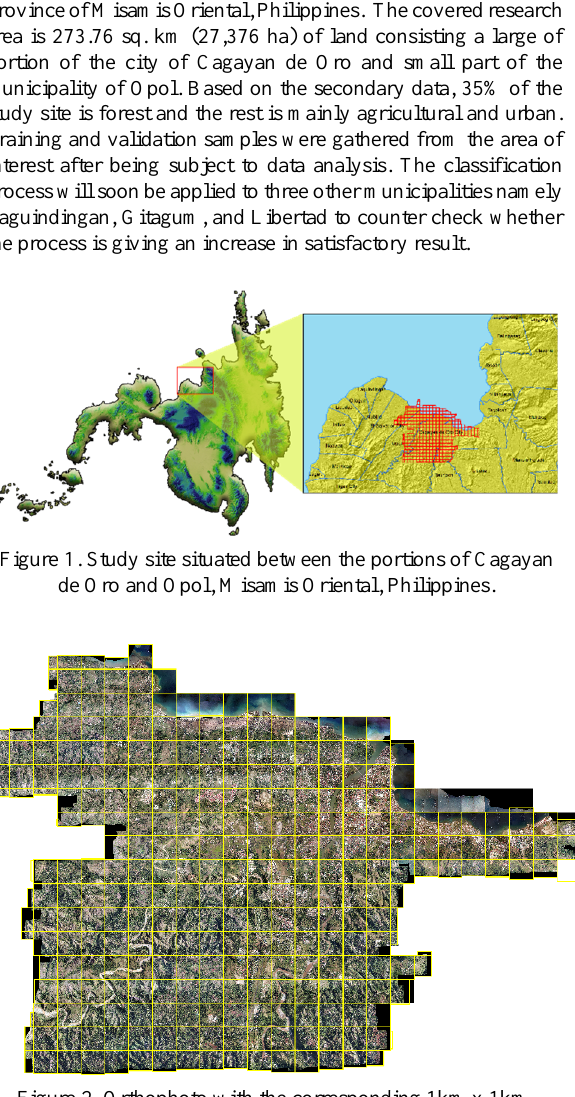
Figure 2. Orthophoto with the corresponding 1km x 1km LiDAR